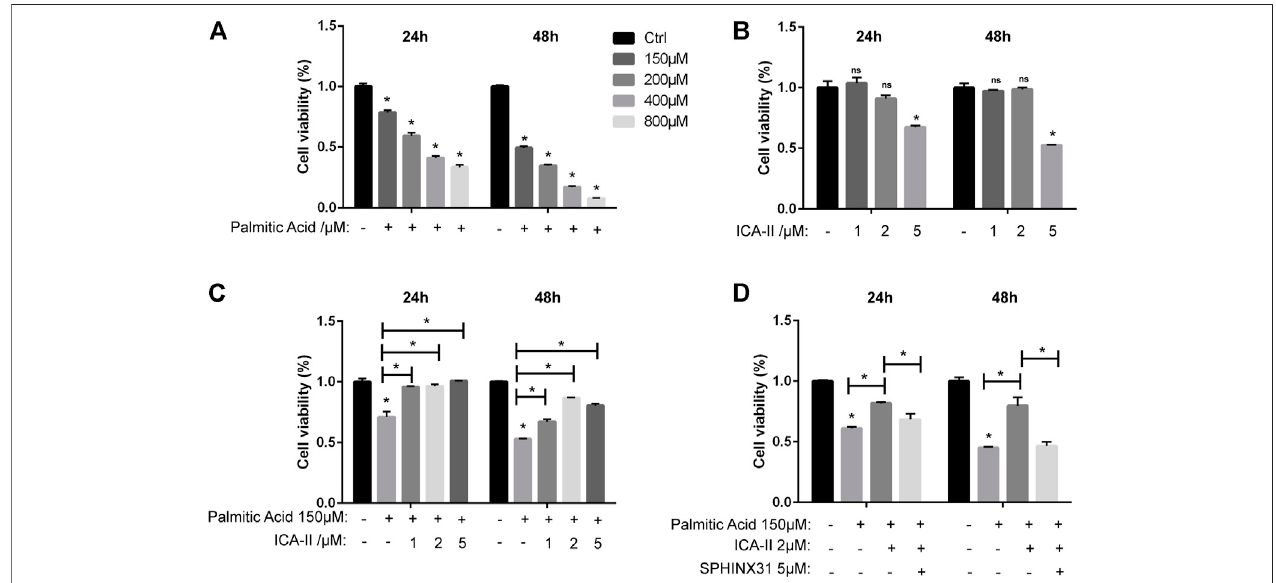
FIGURE 8 | ICA Ⅱ restores cell survival through SRPK1-Akt-eNOS pathway in PA-treated HUVECs. (A) HUVECs were treated with different concentrations of PA (150, 200, 400, and 800 μ M) for 24 and 48 h with cell viability measured via the CCK-8 assay. (B) HUVECs were treated with different concentrations ofICA Ⅱ (1, 2, and 5 μ M)for24and48 hwithdrugtoxicityofICA Ⅱ measuredviatheCCK-8assay. (C) HUVECsweretreatedwith150 μ M PAinthepresenceorabsenceofICA Ⅱ (1,2,and 5 μ M) for 24 and 48 h with cell viability measured via the CCK-8 assay. (D) Cells were treated with 5 μ M SPHINX31 and 150 μ M PA, followed by the presence or absence of 2 μ M ICA Ⅱ for 24 and 48 h with cell viability measured via the CCK-8 assay. The data are presented as the mean ± SD of three independent experiments. Signi fi cance was determined by two-way ANOVA with Bonferroni test. ns, p > 0.05; *, p < 0.05 vs Ctrl.